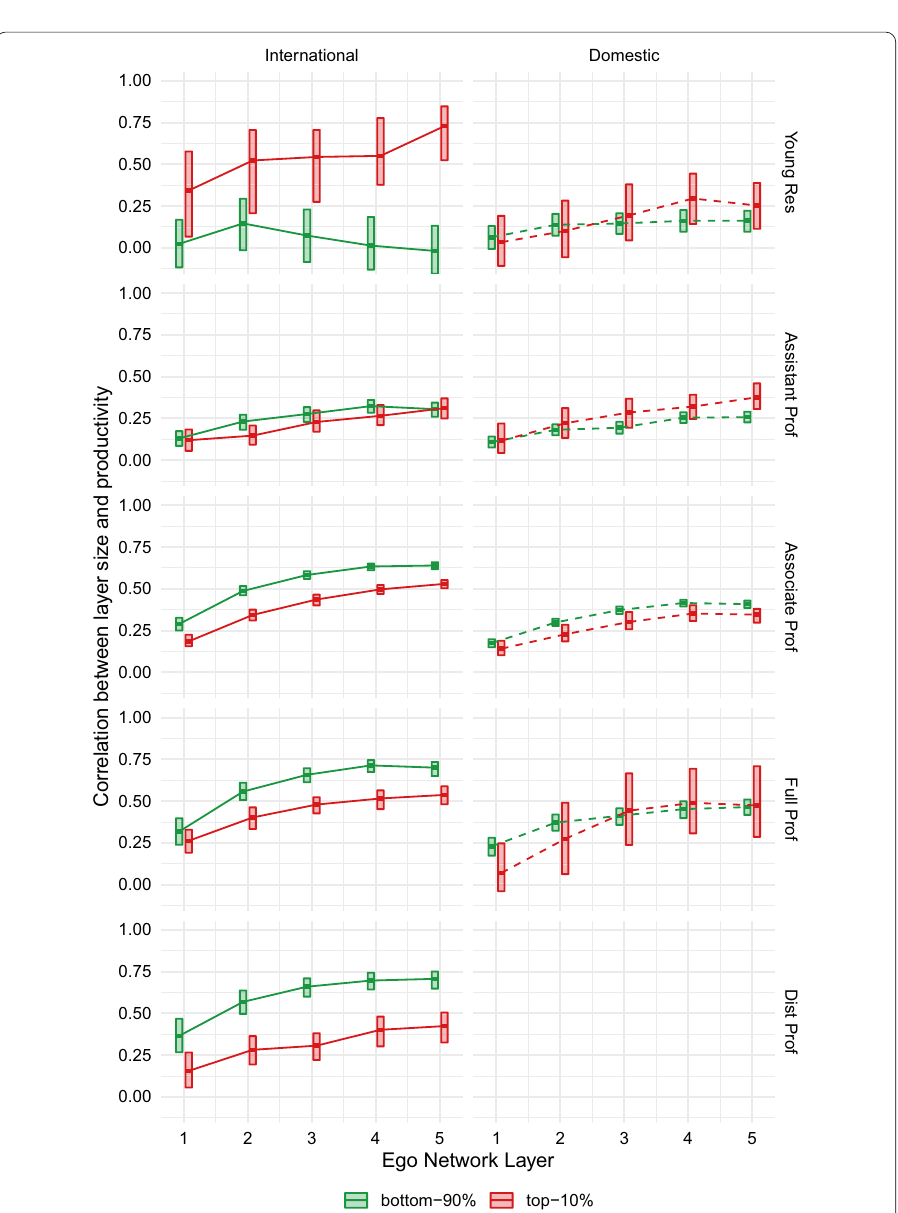
Fig. 13 Mobility intensity and co-authorship ego networks. Correlation between ego network layer size and number of institutions changed, for highly mobile authors (red) and regular authors